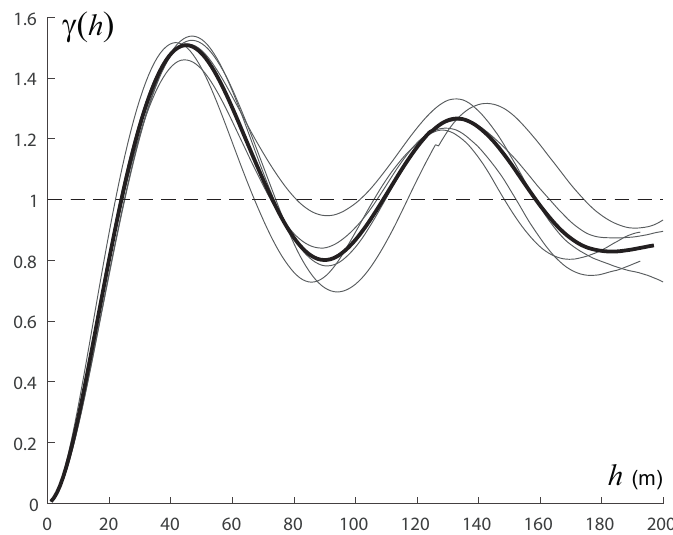
Figure 9. Estimation of the (normalized) spatial variogram from the five Coastal Division profiles (gray lines), along with the average of these variograms (thick black line). The periodic behaviour of the variogram is associated with the alternance between bars and troughs along the profiles, with an average bar-trough distance of about 45